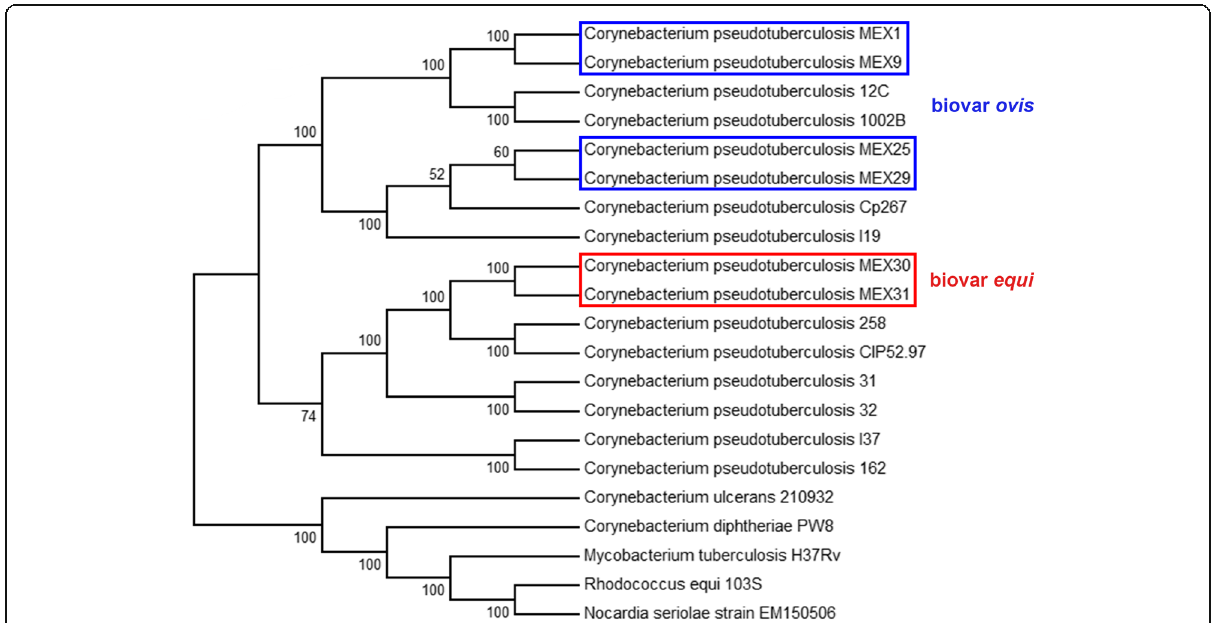
Fig. 1 Phylogenetic tree of new Corynebacterium pseudotuberculosis strains of this work inside the rectangles, with other strains of the group CMNR. The blue rectangles highlight the biovar ovis strains and the red rectangle highlights the biovar equi strains of this work. The numbers near the nodes indicate bootstrap values